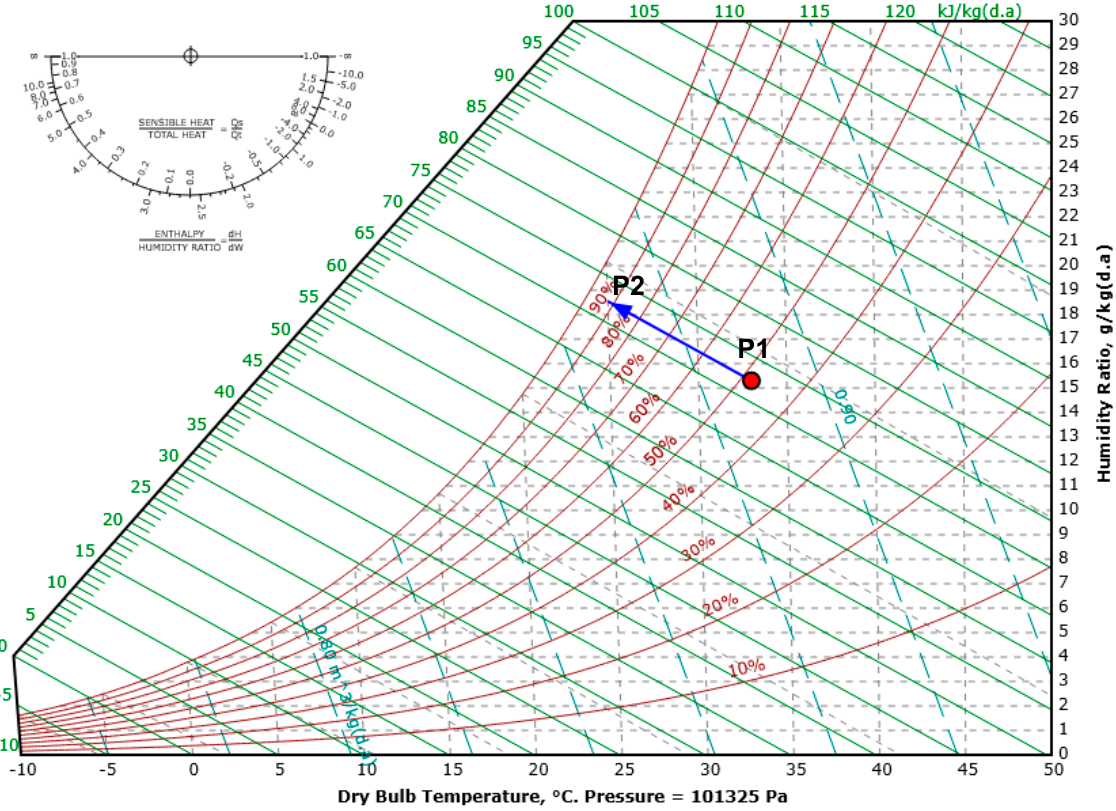
Figure 1. Example of efficiency of an evaporative system.